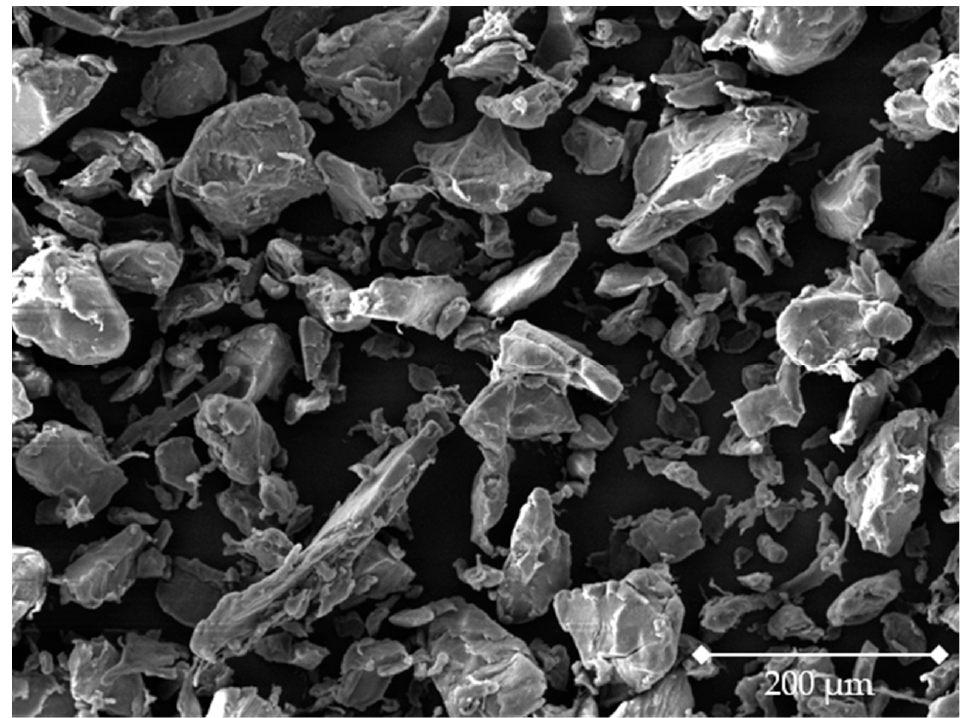
Figure 2. SEM image of the used sinter material. Produced with Tescan Mira 3 at 150× magnifica- tion.